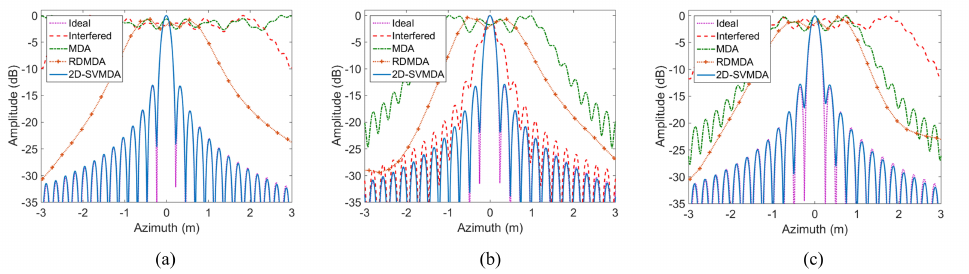
Figure 13. Azimuth impulse response curve comparison of Point A, B, and C. ( a ) Point A. ( b ) Point B. ( c ) Point C. Table 7. Statistical focus comparison of ideal, 2D spatial-variant error interfered, MDA processed, RDMDA processed and 2D-SVMDA processed simulated point